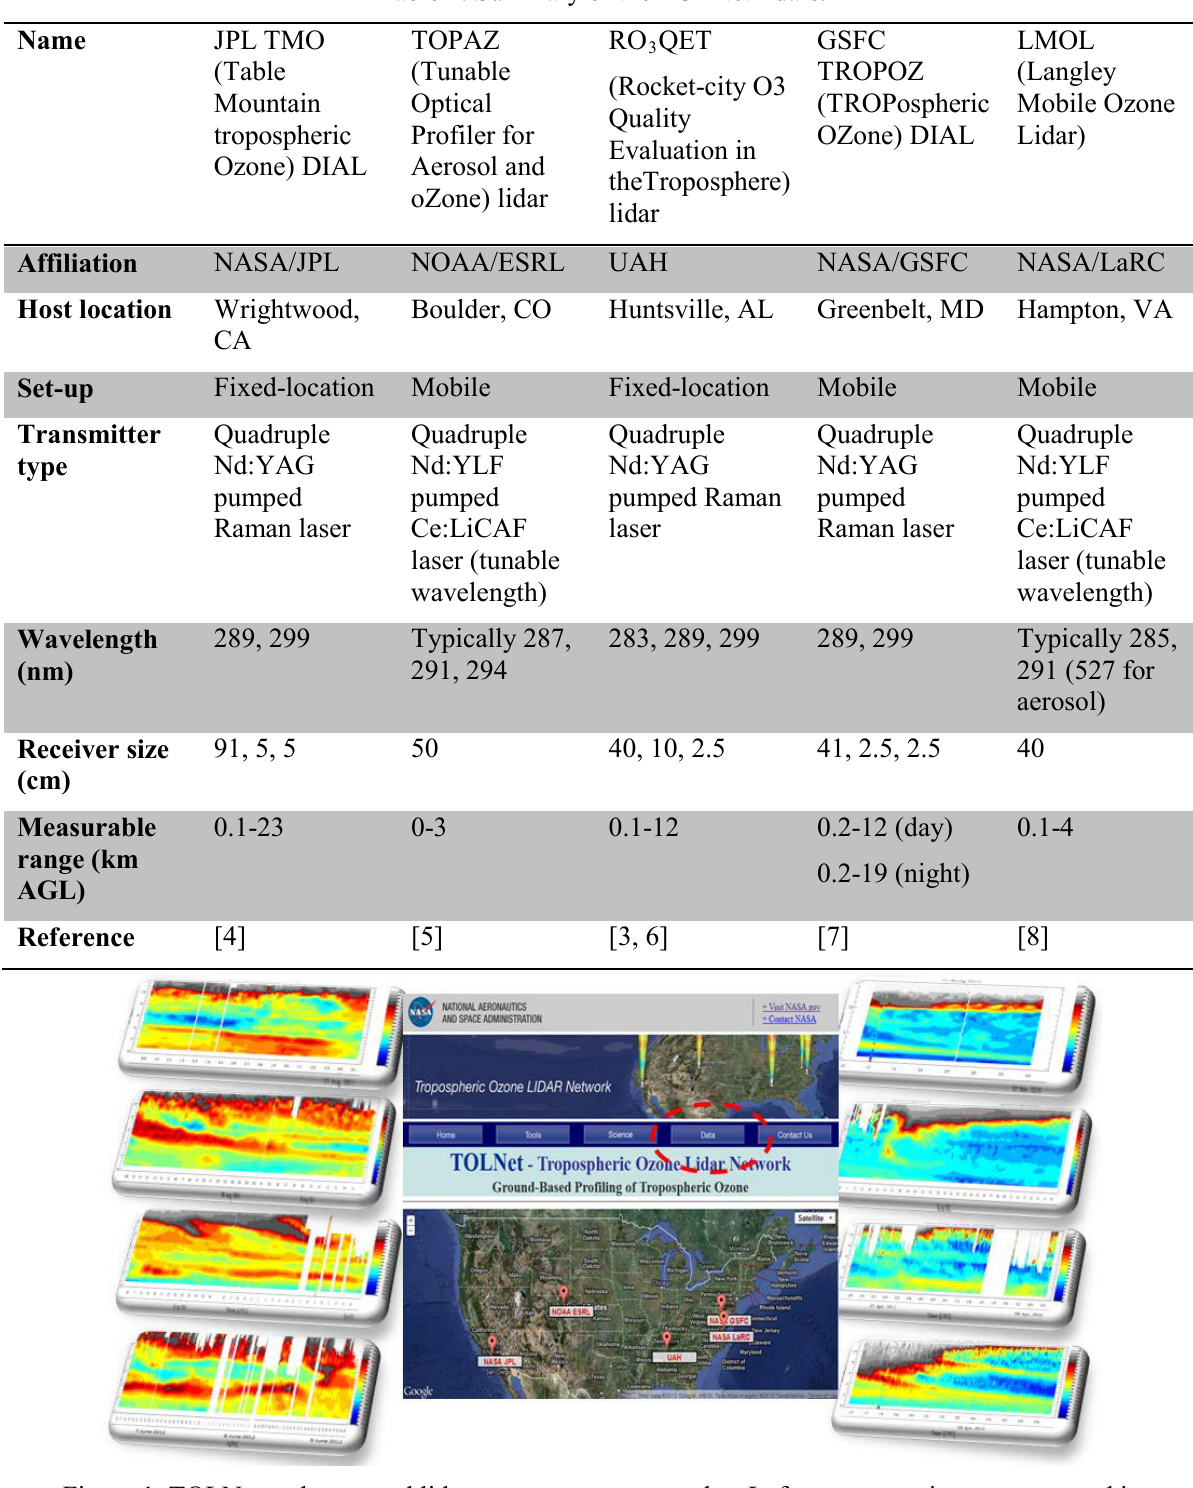
Table 1. Summary of the TOLNet lidars.